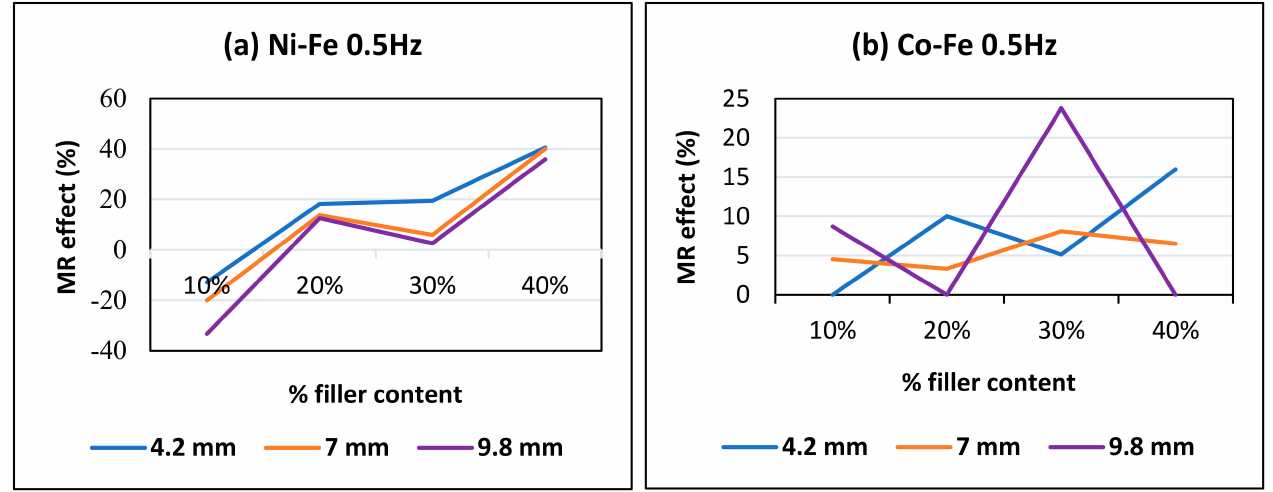
Figure 15. MR effect against every percentage of filler content for ( a ) Ni-Fe MREs and ( b ) Co-Fe MREs.